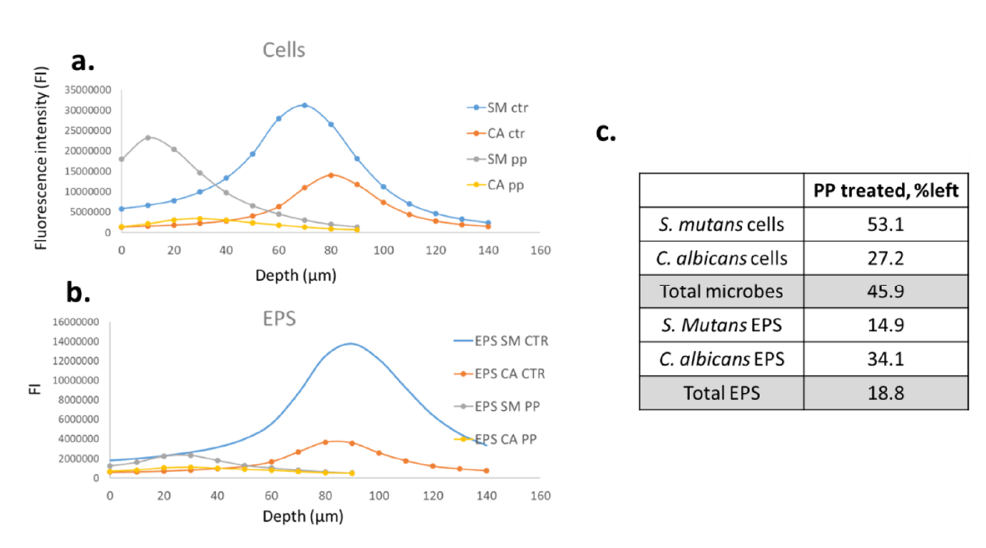
Figure 3. Quantification of the confocal laser scanning microscopy results. Charts a + b show the fluorescence intensity in each layer of the biofilm depth. ( a ) Cells quantification of the control and the treated groups. ( b ) EPS quantification of the control and the treated groups. ( c ) A table summing up the percentage of cells and EPS left after the various treatments relative to the control. In total, the combined cell growth of S. mutans and C. albicans was inhibited by 54% and their EPS production by